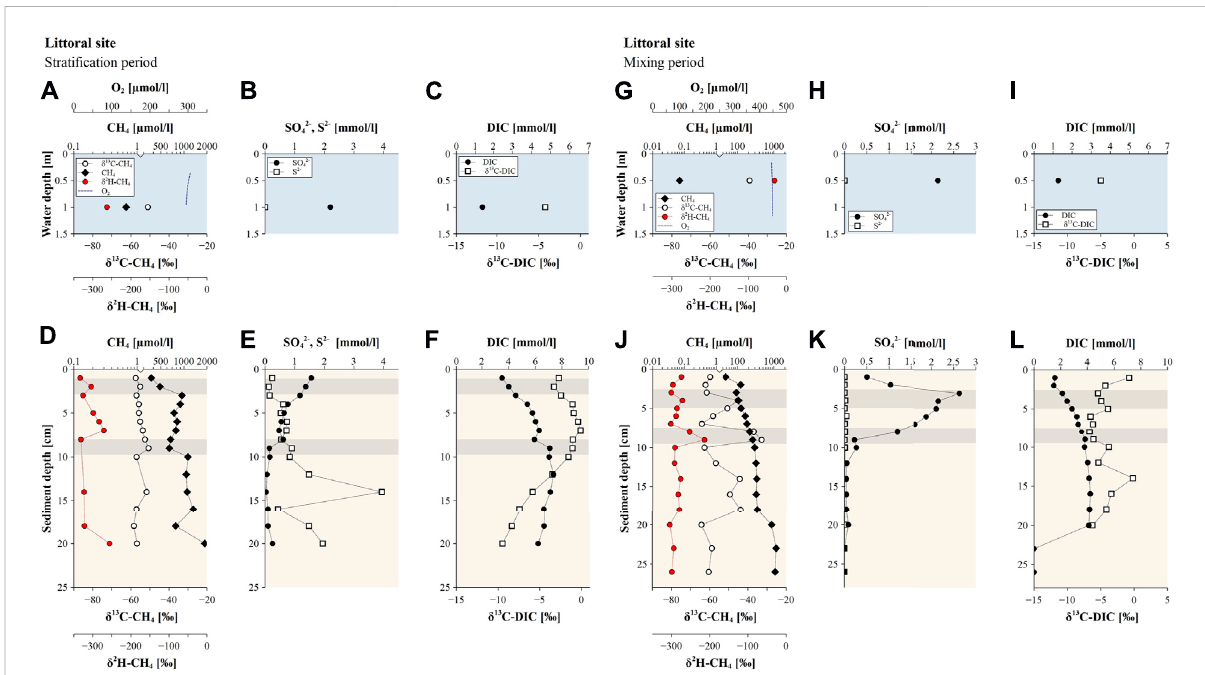
FIGURE 5 Methane (CH 4 ) concentrations, δ 13 C-CH 4 and δ 2 H-CH 4 values along with sulfate, sul fi de, dissolved organic carbon (DIC) concentrations and δ 13 C-DIC values observed at the slope site during (A – F) the strati fi cation period (July 2020) and (G – L) the mixing period (March 2021). Blue background colors indicate pro fi les in the water column, orange background colors show pro fi les of sediment cores and grey highlighted sediment depths indicate the occurrence of the SMTZ.